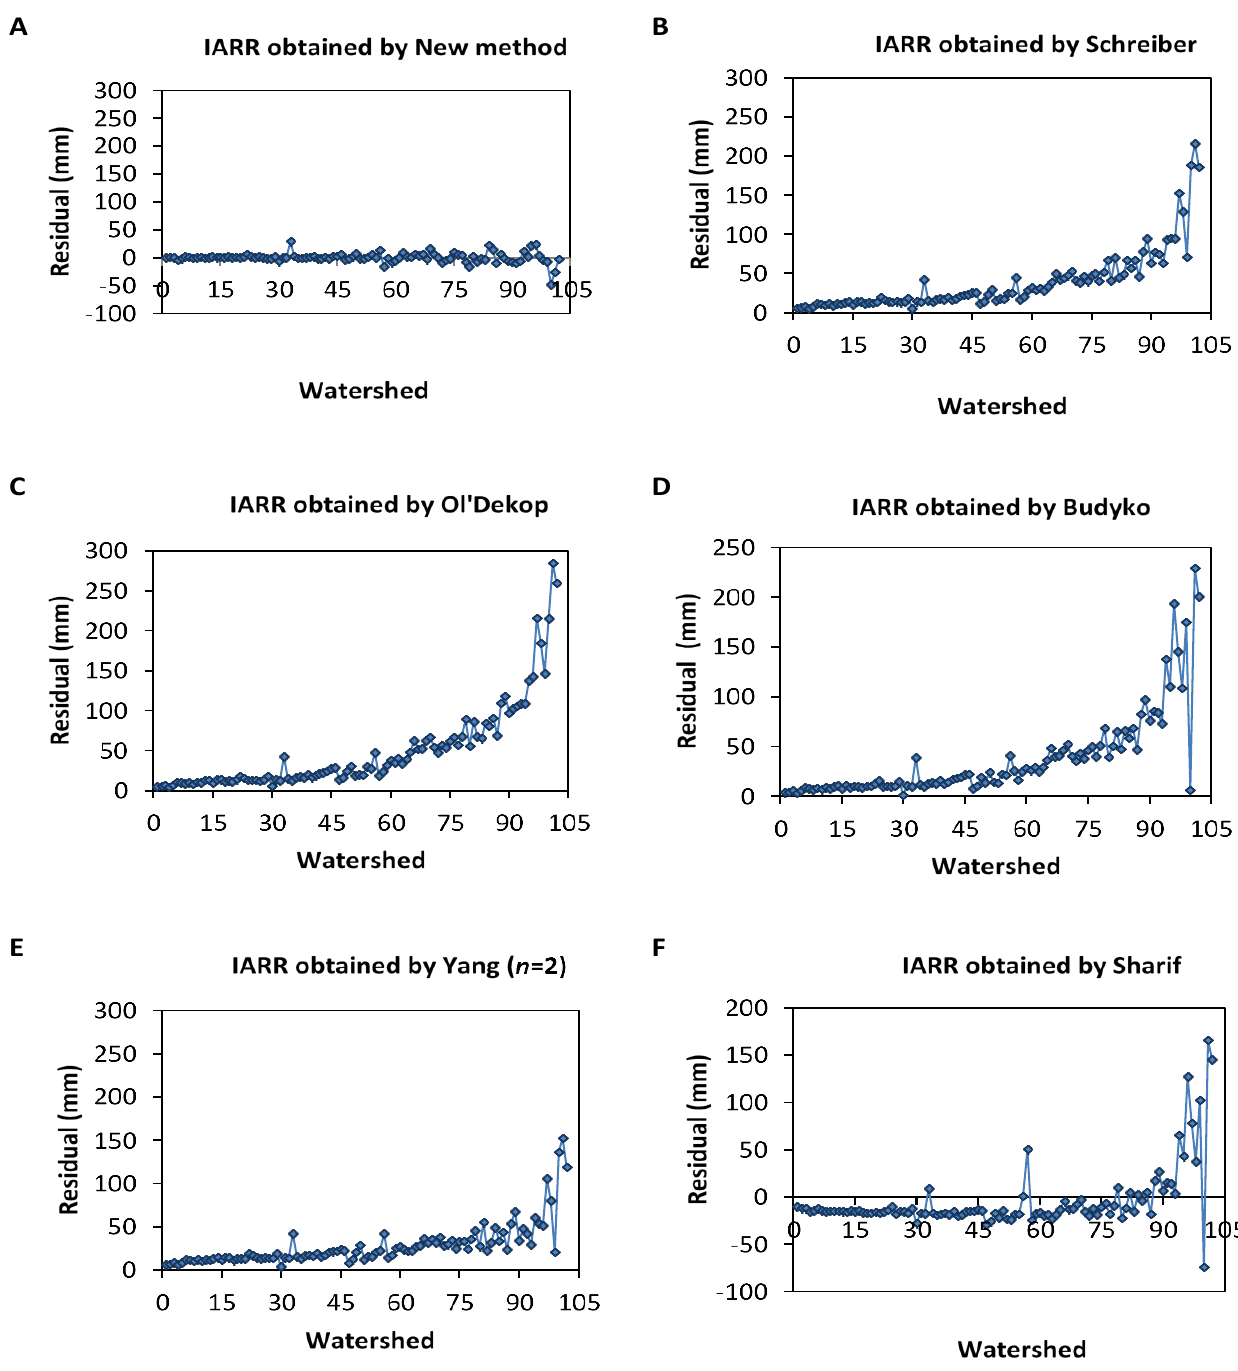
Figure 9. Residual analysis curves between real and estimated interannual rainfall-runoff (IARR), which is obtained by applying a new method ( A ), Schreiber ( B ), Ol’Dekop ( C ), Budyko ( D ), Yang ( E ), and Sharif ( F ) models.